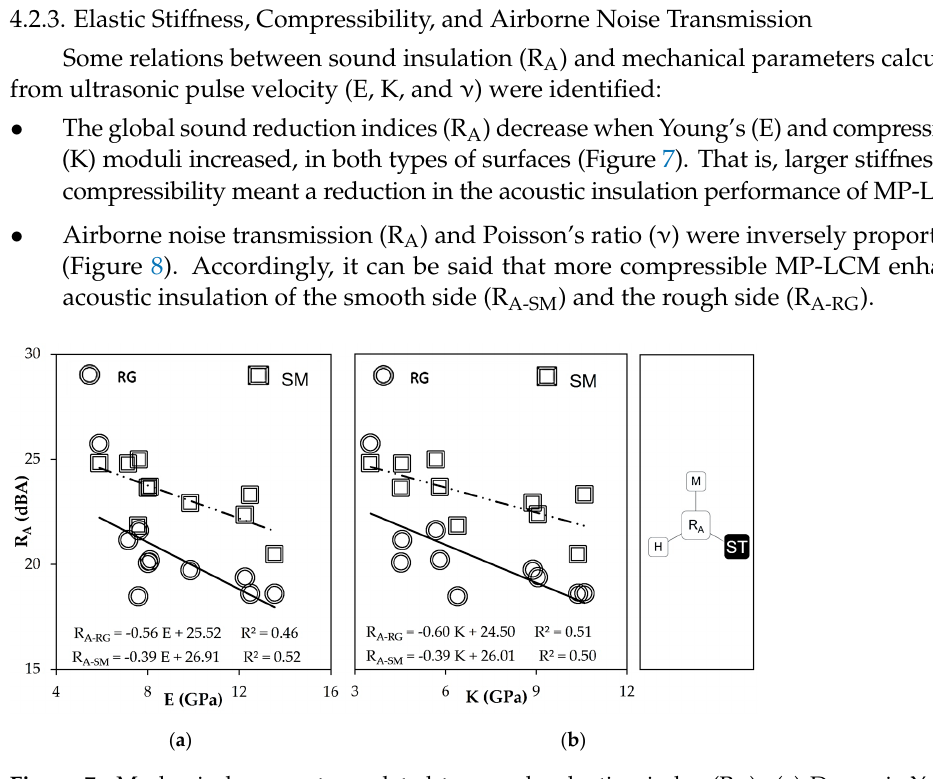
) ( b ) and water vapor permea- O